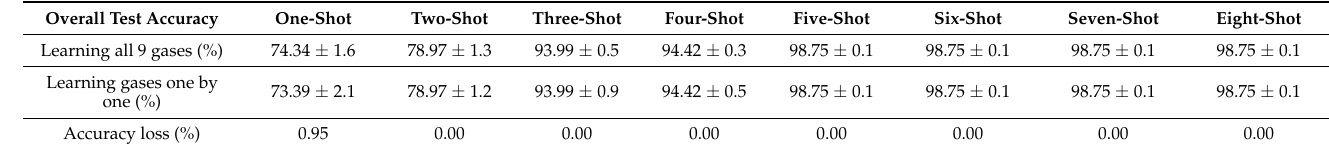
Table 2. The test accuracy of the proposed SNN with two different learning methods.